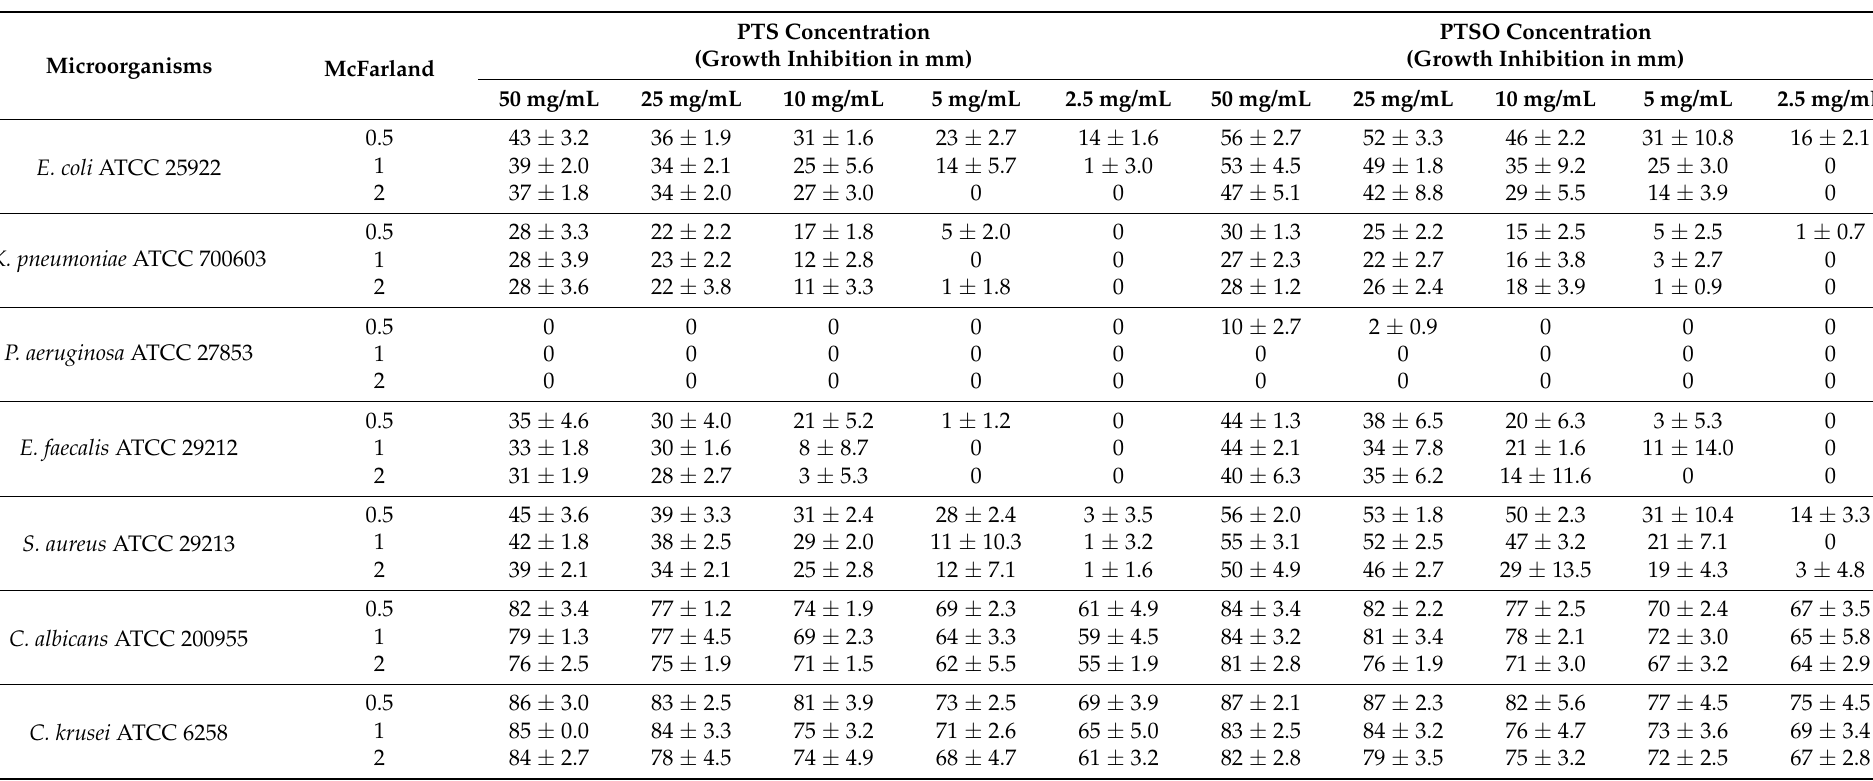
Table 2. Average diameter ± standard deviation (in mm) of the growth inhibition halos for the different PTS and PTSO concentrations, in each inoculum (0.5, 1, and 2 from McFarland) and for the different